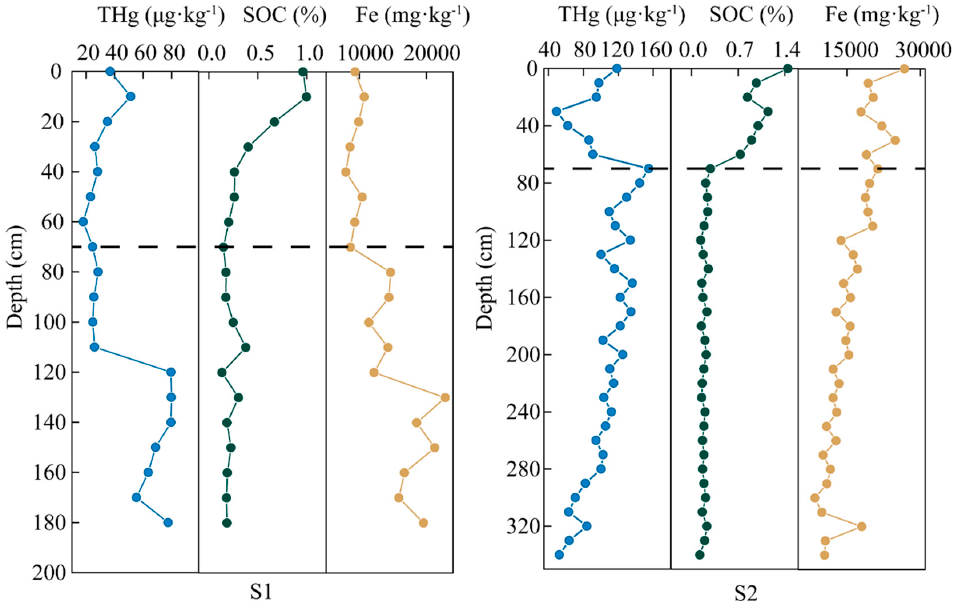
Figure 3. Vertical distribution patterns in forest soil profiles, including THg, SOC, and Fe contents.